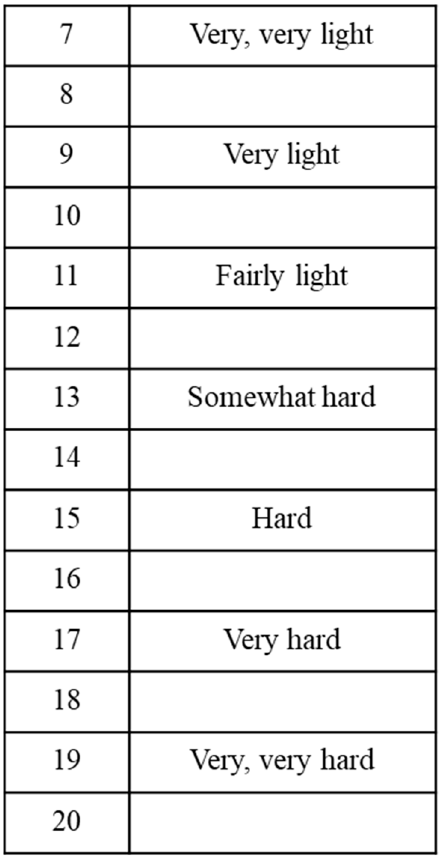
Figure 1. Borg rating of perceived exertion scale.